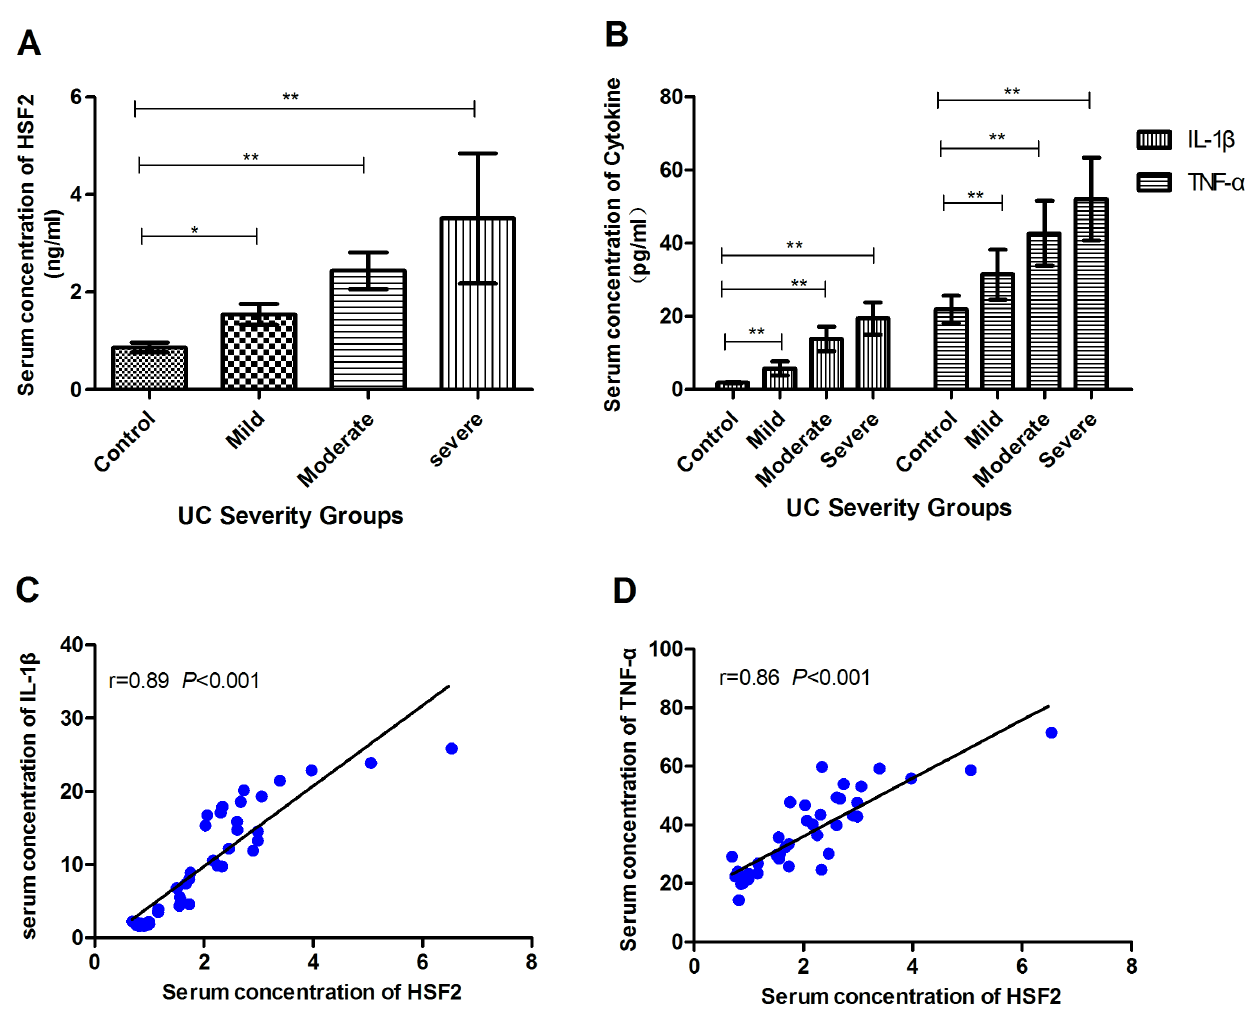
Figure 5. The concentration of HSF2, IL-1 b and TNF- a in serum was determined by ELISA. A : serum concentration of HSF2 in patients with UC of varying severity. B: serum concentrations of IL-1 b and TNF- a of different UC severity groups. C: Correlation analysis between the concentrations of HSF2 and IL-1 b . D: Correlation analysis between the concentrations of HSF2 and TNF- a .Correlation analysis was assessed using the Pearson Test which gives a correlation coefficient (Pearson ‘‘r’’) and a ‘‘ p ’’ value. *, p , 0.05; **, p ,